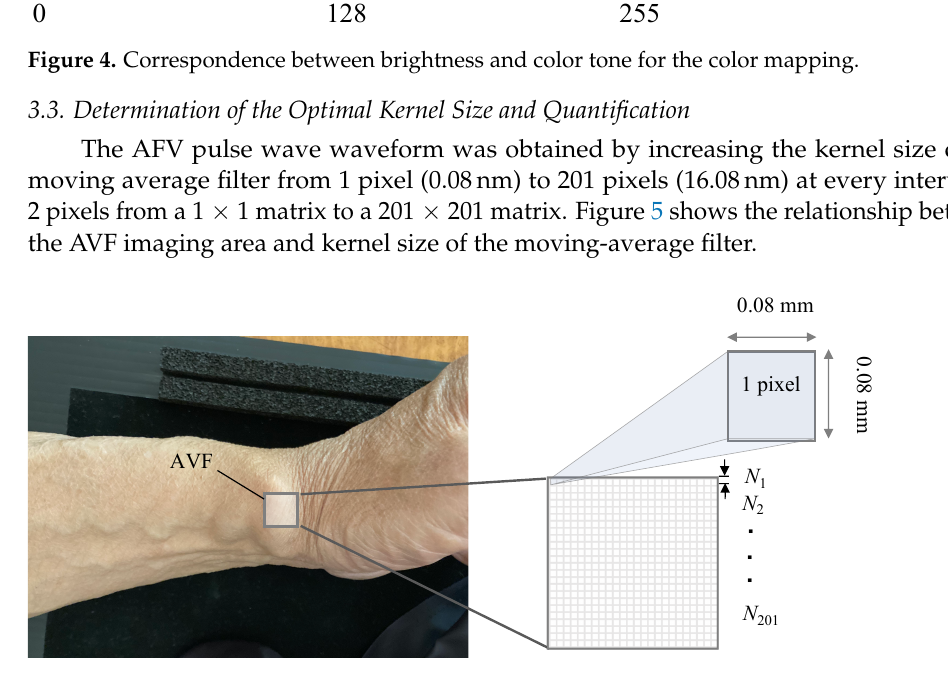
Figure 5. AVF imaging area and the kernel size ( N × N ) of the moving-average